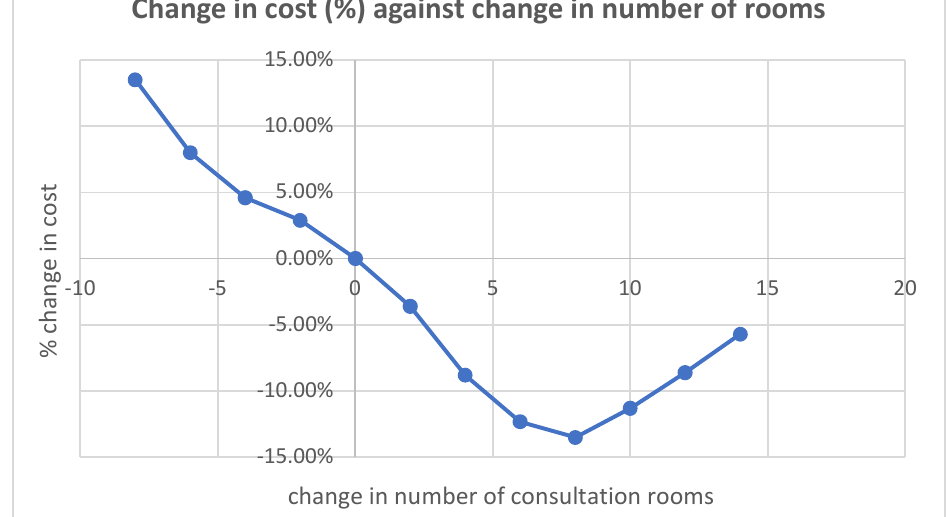
Figure 1. Change in total price against change in the number of rooms.